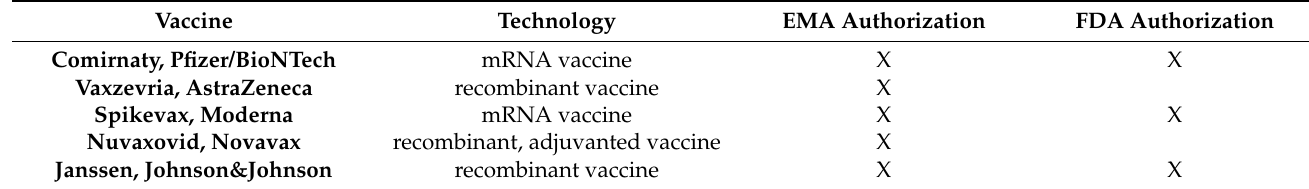
Table 1. Overview of approved COVID-19 vaccines. Legend: X = accepted [10,11]. Vaccine